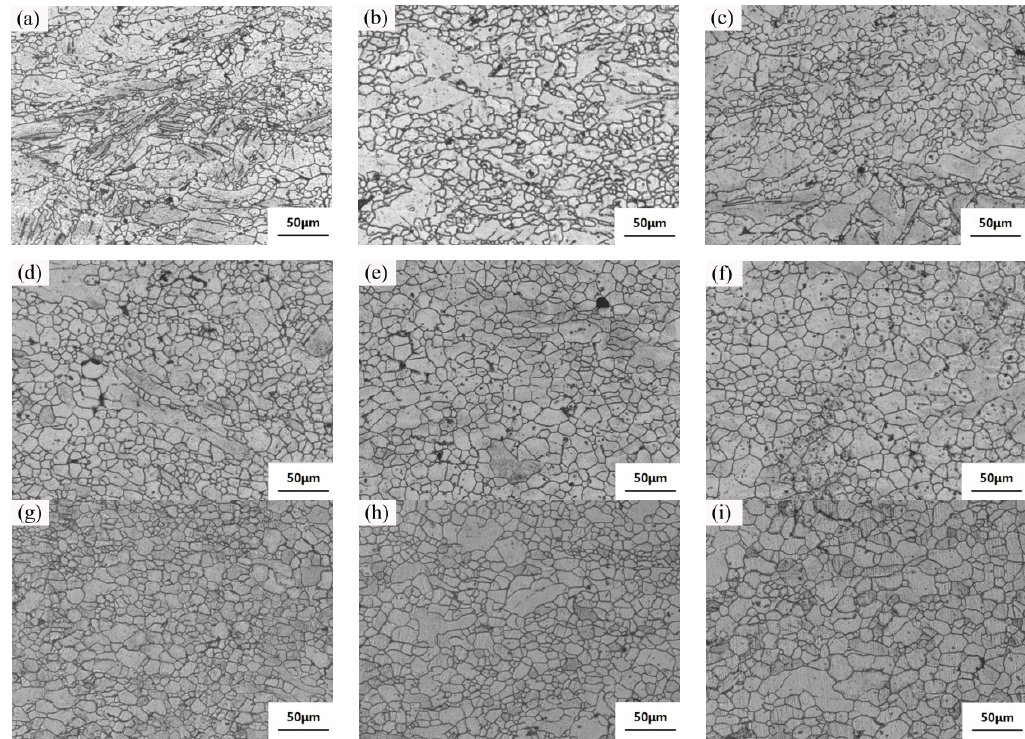
Figure 15. Optical microstructure of the samples after post heat treatments of: ( a ) 440 °C—1 h, ( b ) 440 °C—2 h, ( c ) 440 °C—3 h, ( d ) 480 °C—1 h, ( e ) 480 °C—2 h, ( f ) 480 °C—3 h, ( g ) 520 °C—1 h, ( h ) 520 °C—2 h, ( i ) 520 °C—3 h.